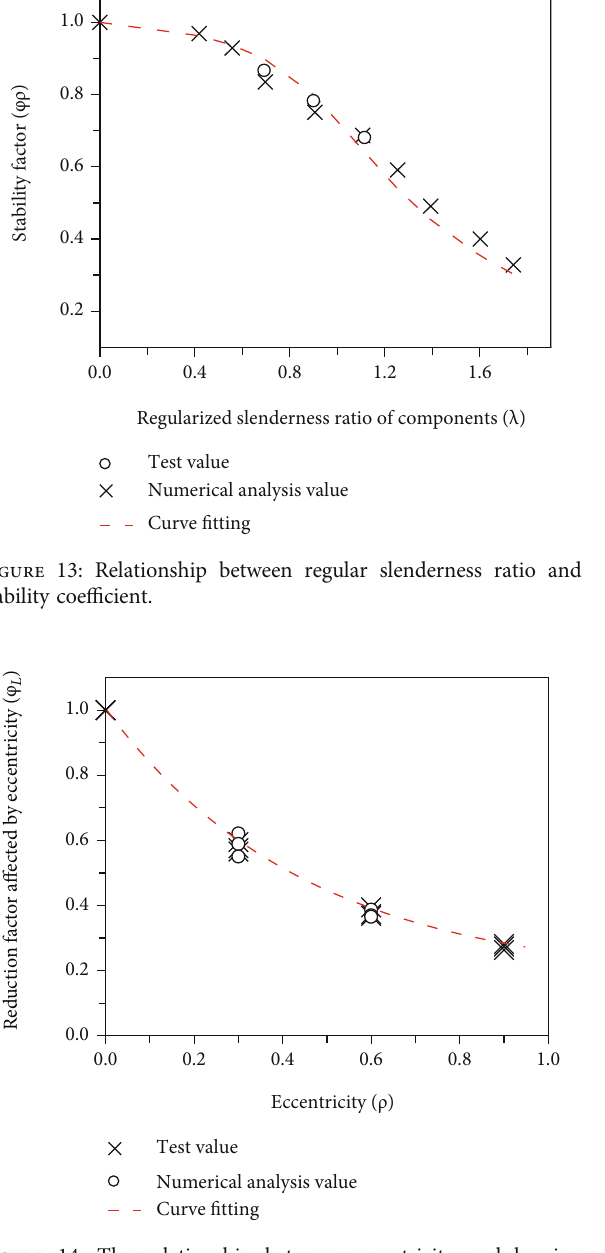
Figure 14: The relationship between eccentricity and bearing capacity reduction.